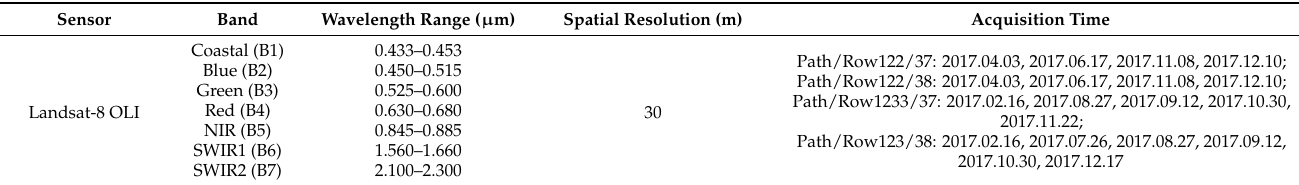
Table 3. Spectral bands and acquisition dates of MODIS in the